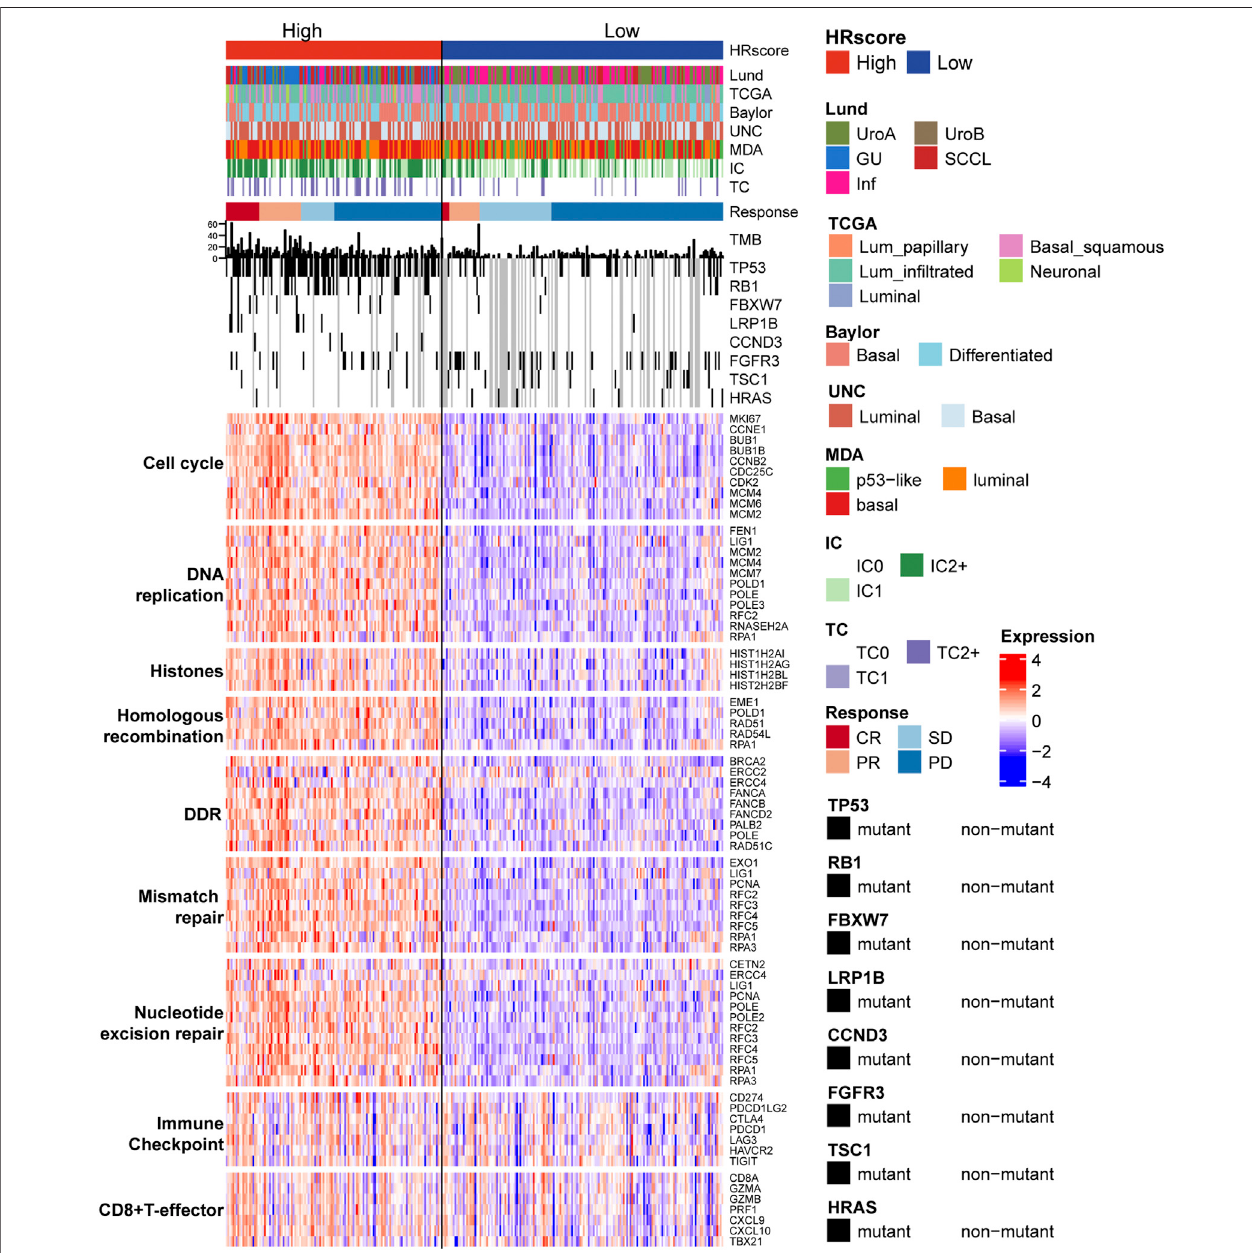
FIGURE5 | The relationship between HRscore groups, differentsubtypes, and core biological pathways.Rowsofthe heat map show gene expression (z-scores) groupedbypathway.Lund,LundUniversity;TCGA,TheCancerGenomeAtlas;MDA,MDAndersonCancerCenter,UNC,UniversityofNorthCarolina;HR,homologous